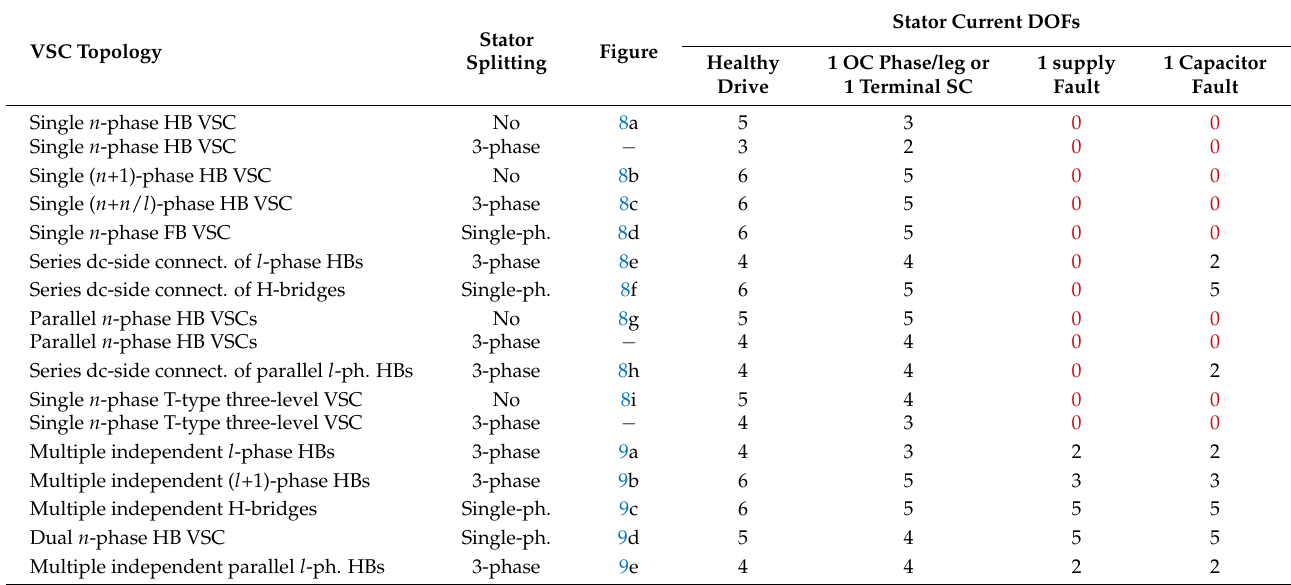
Table 31. Values obtained from Table 29 for the particular case of n = 6 with ξ = 1 ( ξ (cid:48) = 0).